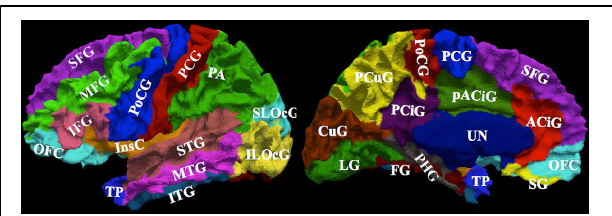
FIGURE 3 | Thesurfaceonthesubjectwiththemedianoverlapmanually parcellated into 24 sub-regions. The full name of each region is given in Table 4 . The surface is shown in a lateral (left) and a medial (right) view.